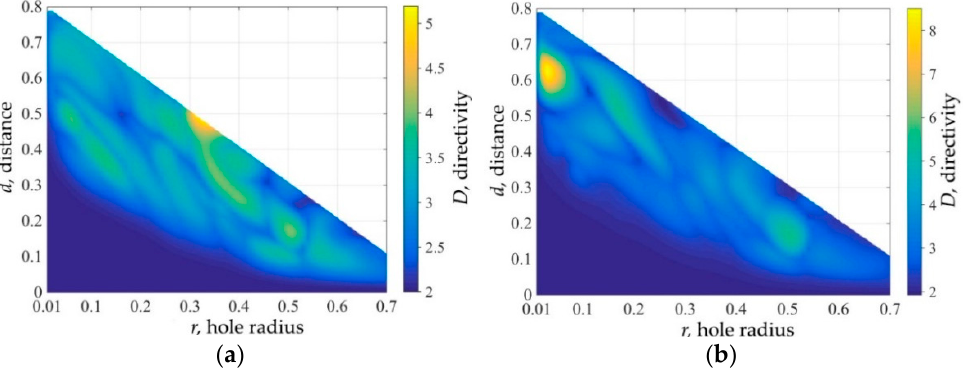
Figure 2. Dependence of the directivity 𝐷 for the modes (11, 1, 𝑒/𝑜 ) on the relative distance 𝑑 between the centers of the cavity and the hole and the relative radius 𝑟 of the hole, ( a ) odd mode, and ( b ) even mode.